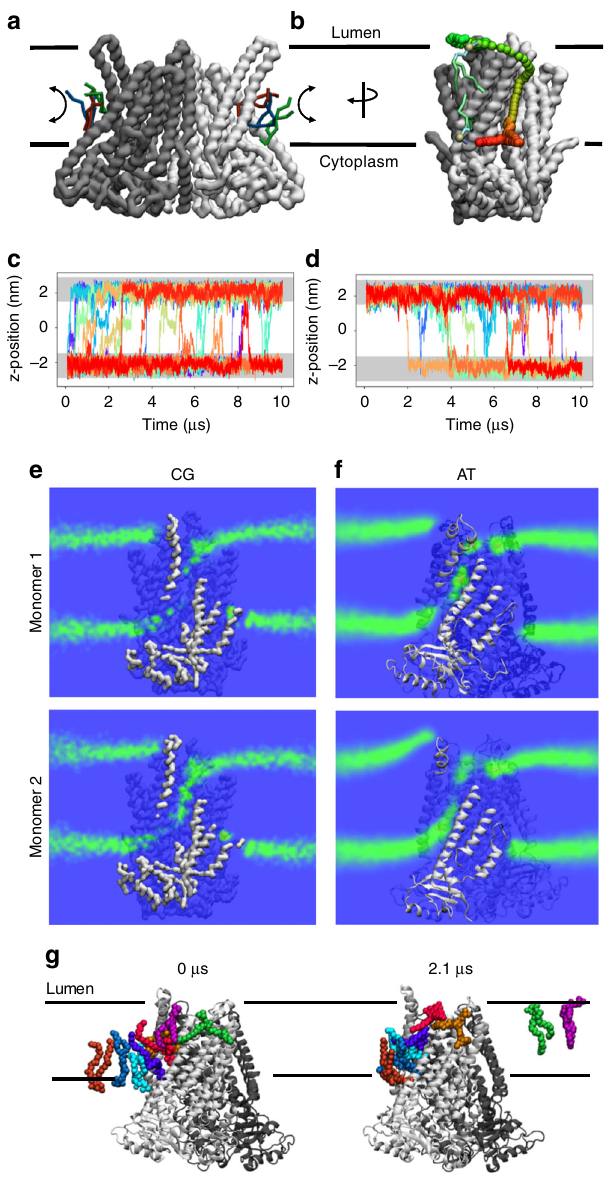
Fig. 5 CG and atomistic MD simulations of TMEM16K structures reveal lipid scrambling. a View of CG TMEM16K after ~8 μ s simulation. The protein backbone surface (grey and white) and scrambling lipid molecules (blue, red and green sticks) are shown, b as panel ( a ), but rotated by 90 o and showing the pathway of a single lipid. The before and after poses are shown as green, blue and cyan sticks, with the phosphate head group particle shown as a gold/grey sphere. The scrambling pathway is denoted by red-to-green coloured spheres from cytoplasmic to luminal side. c , d Traces showing quanti fi cation of CG lipid scrambling, across the z -axis, with the position of phosphate beads in each membrane lea fl et shown in light grey. The traces show c lipids that fl ip from cytoplasmic to lumenal lea fl ets, and those that fl ip in the opposite direction, d , e Density of lipid headgroups along a plane through the membrane, as computed over 10 µ s of CG simulation. Density is scaled from blue to green, with a scrambling pathway clearly visible along the TMEM16K hydrophobic groove. f As panel ( e ) but of 2.1 µ s of atomistic simulation, and calculating the densities of all non-hydrogen head group atoms. The densities reveal a similar pattern to the CG data. g Lipids engaged with the TMEM16K translocation pathway in a 2.1 µ s atomistic simulation, coloured as per panel ( a